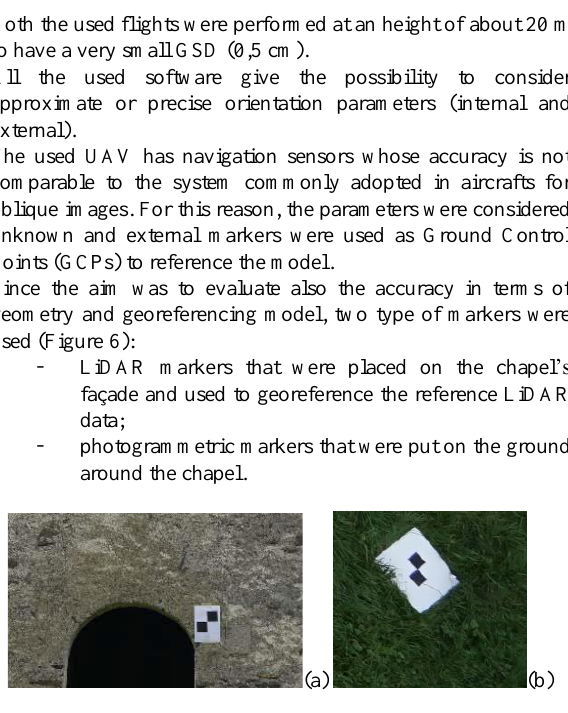
Figure 6. Marker on the Facade (a), and on the terrain (b) Both the markers were measured with topographic Figure 4. Schema of the linear flight-plan for the acquisition of the nadir images (a screenshot of the Mikrokopter tool is in the top right part of the image)